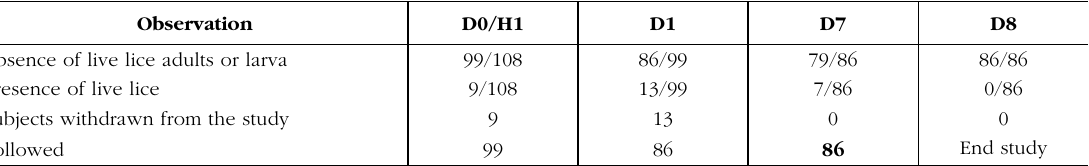
table II. – Pediculicidal and ovicidal efficacy of the study product one hour (d0/h1), one day (d1) and seven days (d7) and eight days (d8) after the first application of the